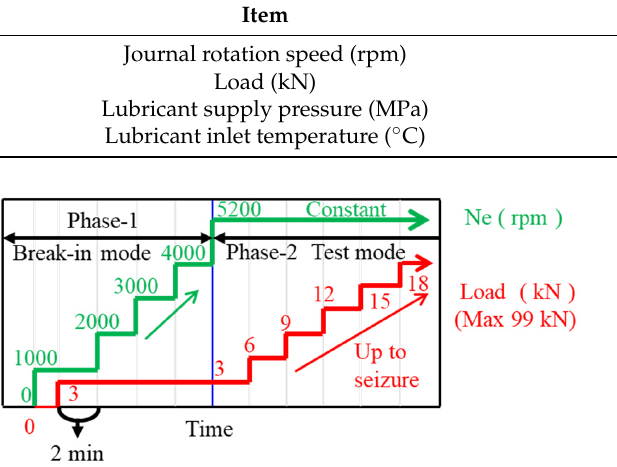
Figure 8. Operating modes in seizure test.